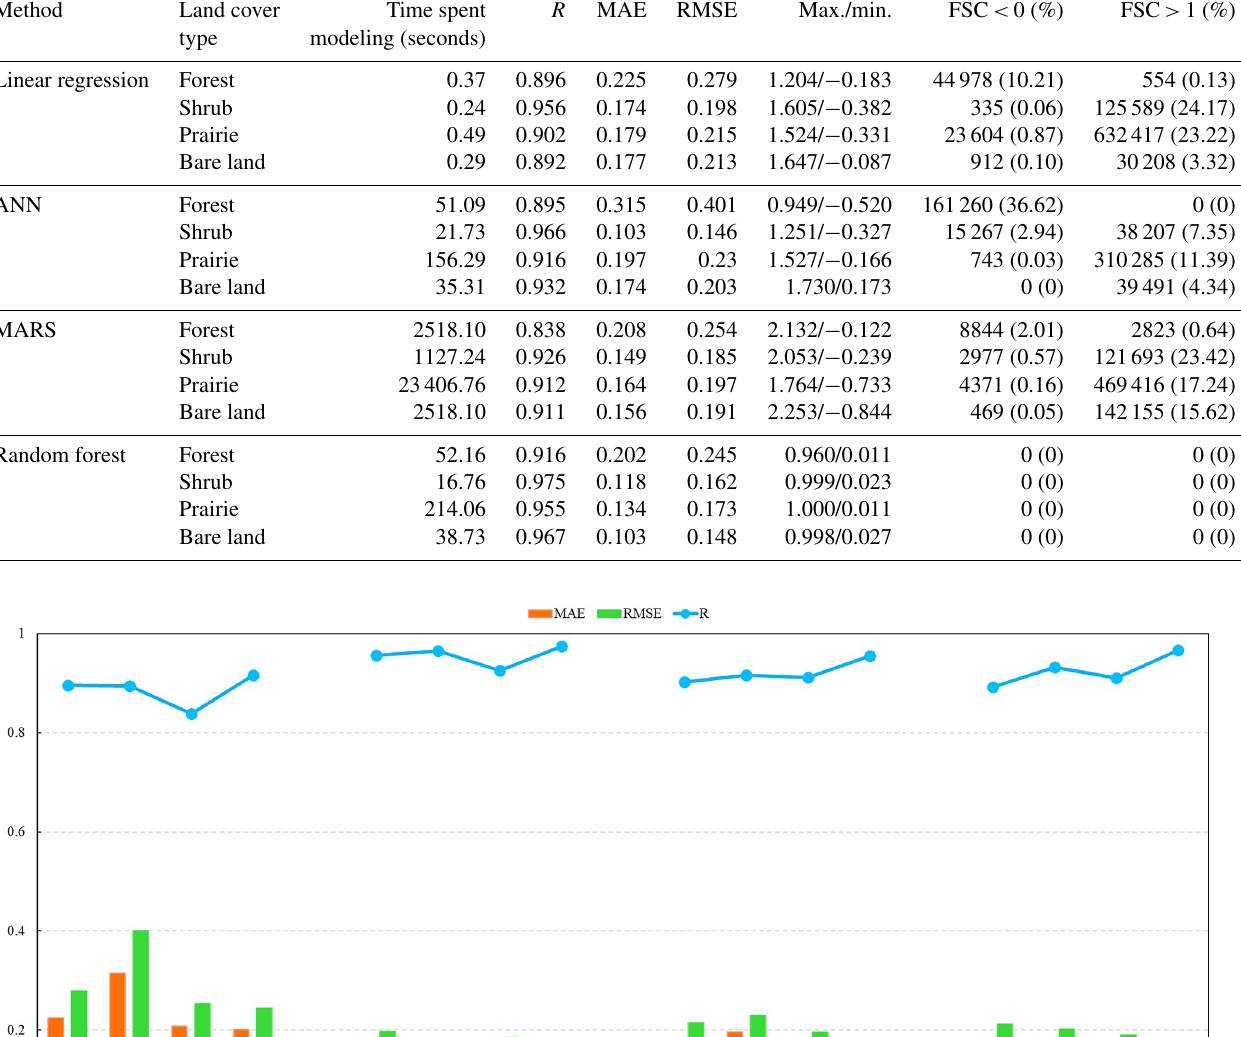
Table 5. Performance of linear regression, ANN, MARS, and random forest model using test datasets from 2010 for four land cover types. FSC indicates fractional snow cover. The number outside parentheses indicates the number of pixels. The number inside brackets indicates their percentage.